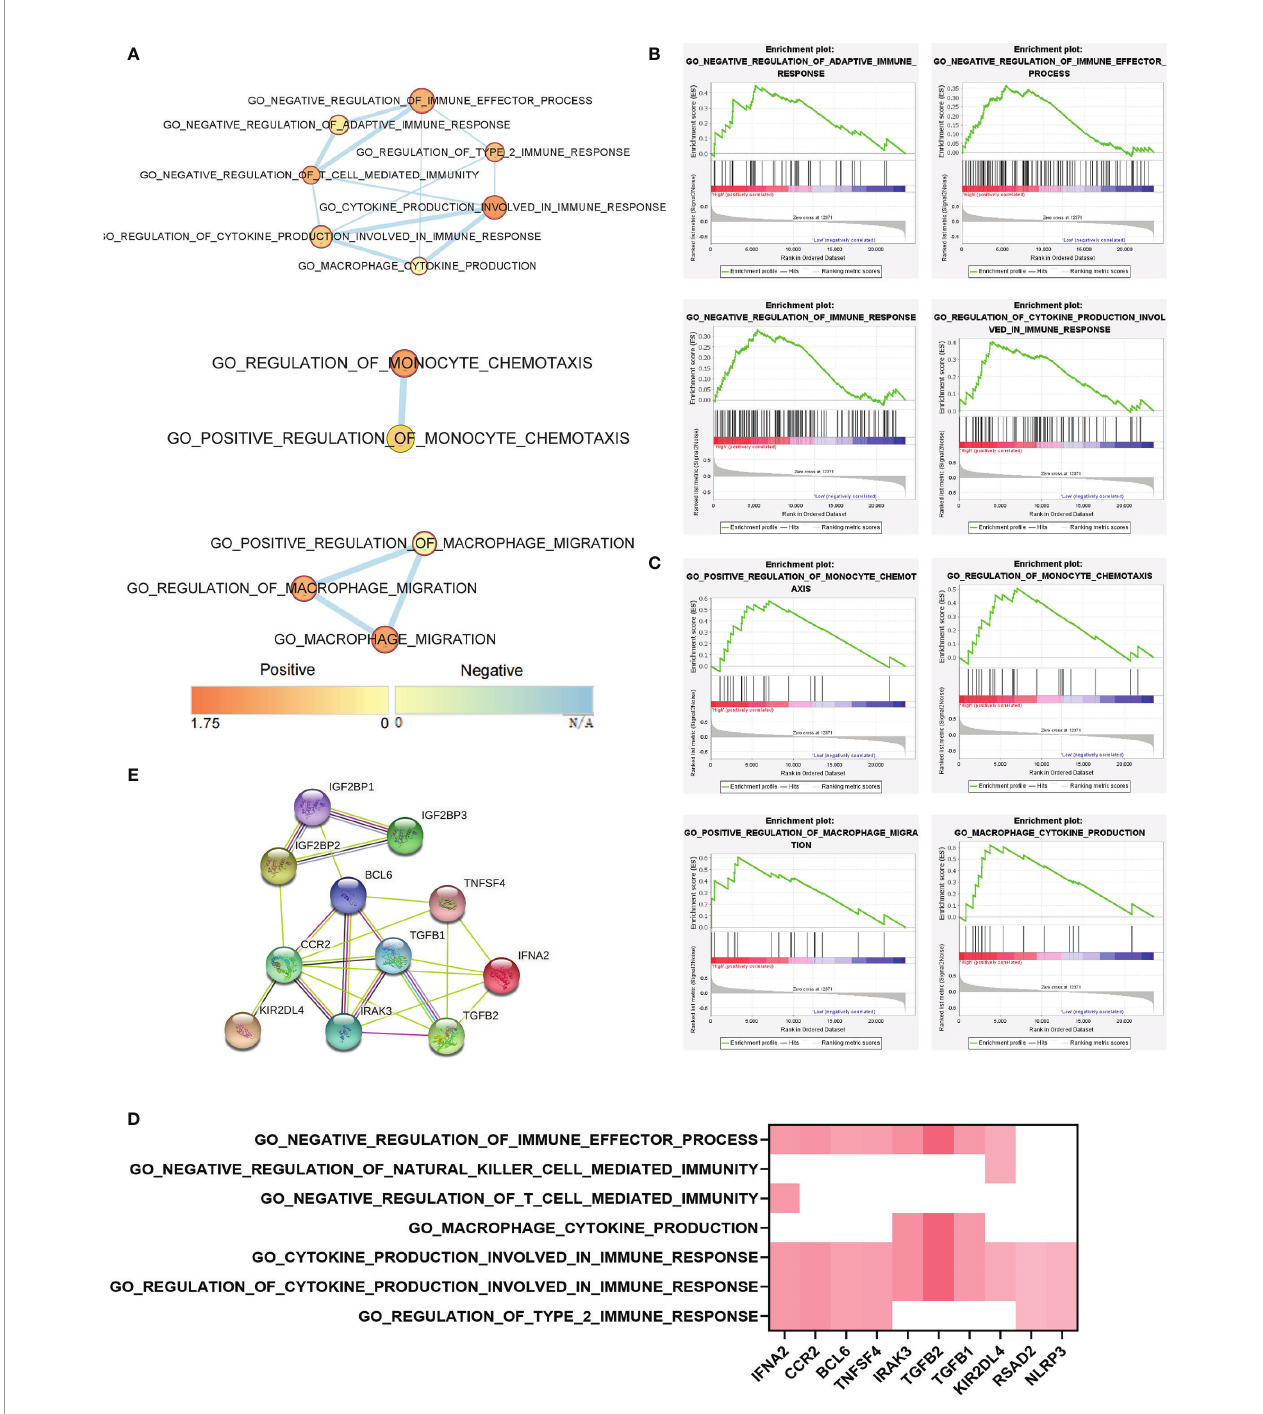
FIGURE 5 | IGF2BP2 involved in the immune response of monocytes in peripheral blood of CRC patients. (A) EnrichmentMap pathways network revealed overlaps among IGF2BP2 high-expressed phenotype enriched pathways relating to immunity in peripheral blood of CRC patients. Nodes are colored by Enrichment Score, and edges are sized on the basis of the number of genes shared by the connected pathways. (B) GSEA indicated that IGF2BP2 was negatively correlated with the immune response of monocytes. (C) GSEA indicated that IGF2BP2 was positively correlated with monocyte chemotaxis and cytokine production. (D) Leading edge analysis of their intersection genes indicates the vital genes shared by the IGF2BP2 high-expressed phenotype associated with the immune response of monocytes. (E) STRING database analysis revealed that IGF2BP2 interacted with the above vital genes related to the immune response of